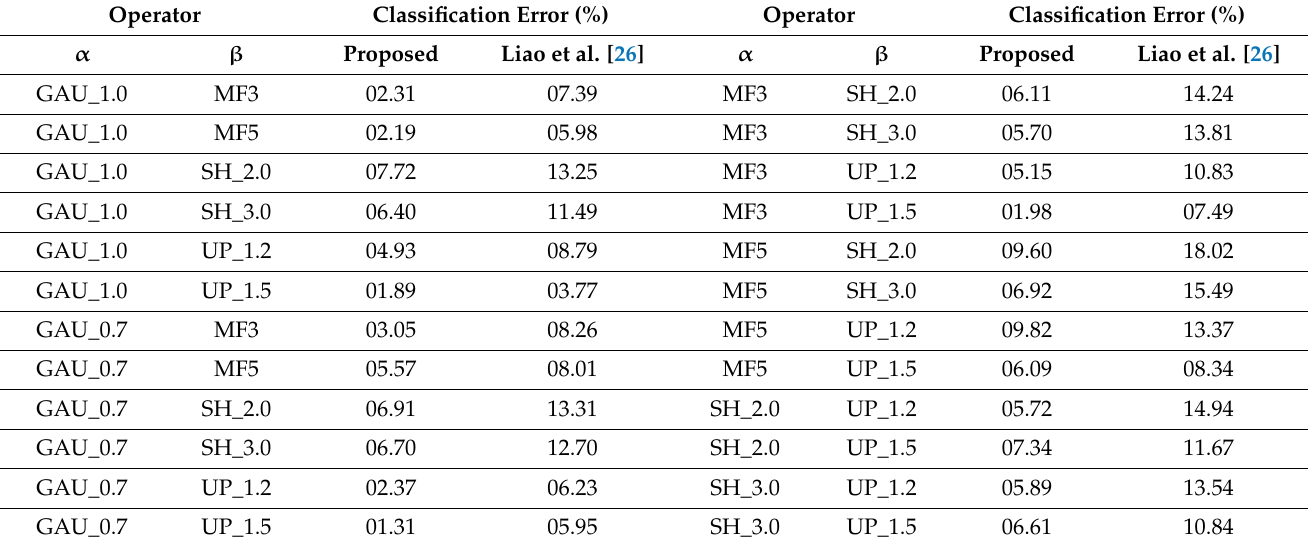
Table 6. Comparative analysis for uncompressed images.